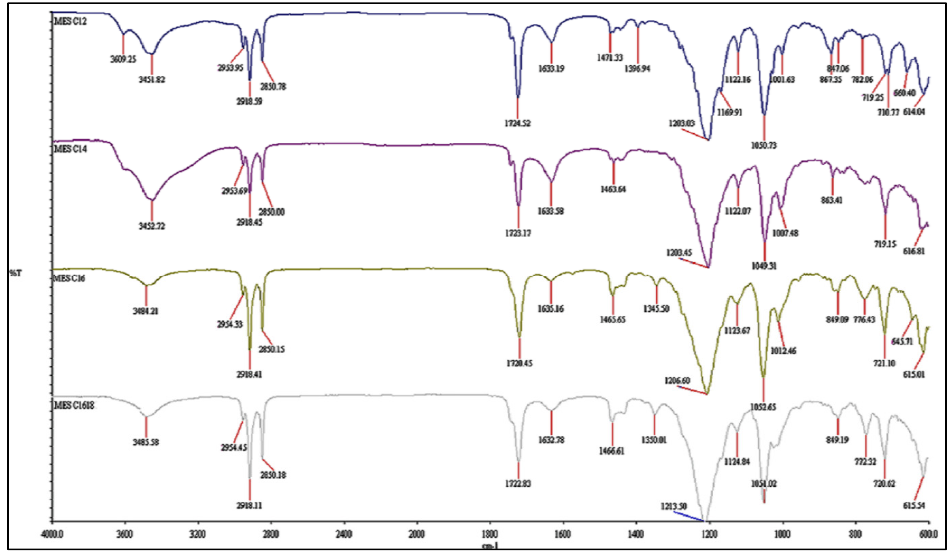
Figure 4. Infrared of MES before crystallization. Molecules 2020 , 25 , x FOR PEER REVIEW